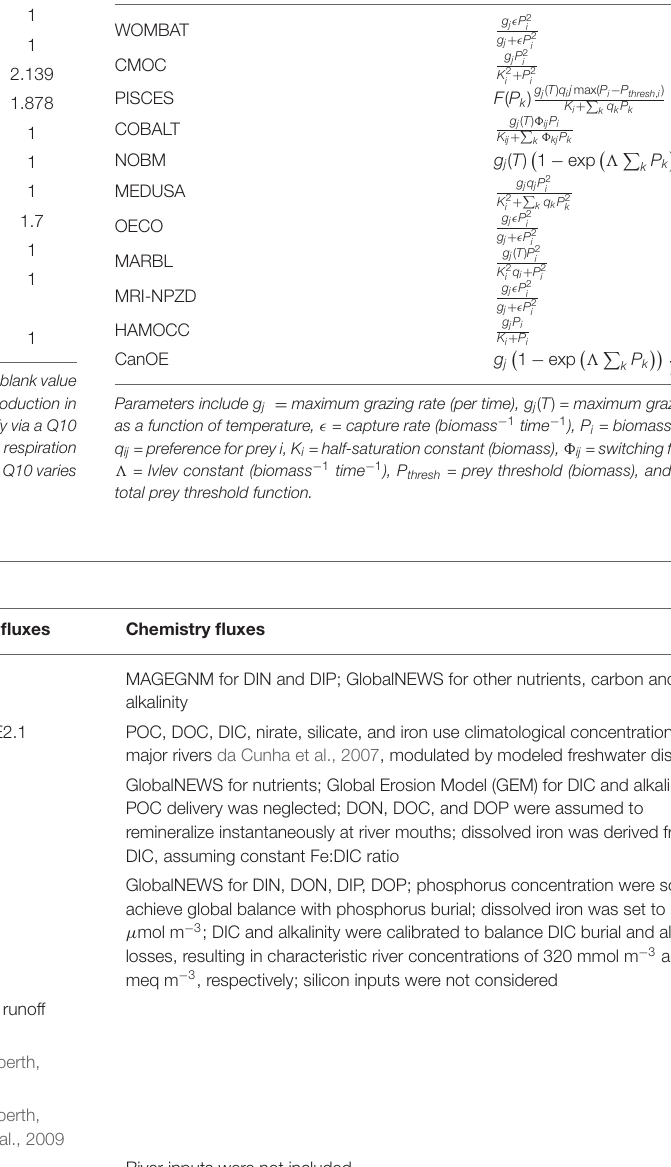
Nitrogen was derived from the land-biogeochemical model; phosphorous was assumed to be in Redfield ratio